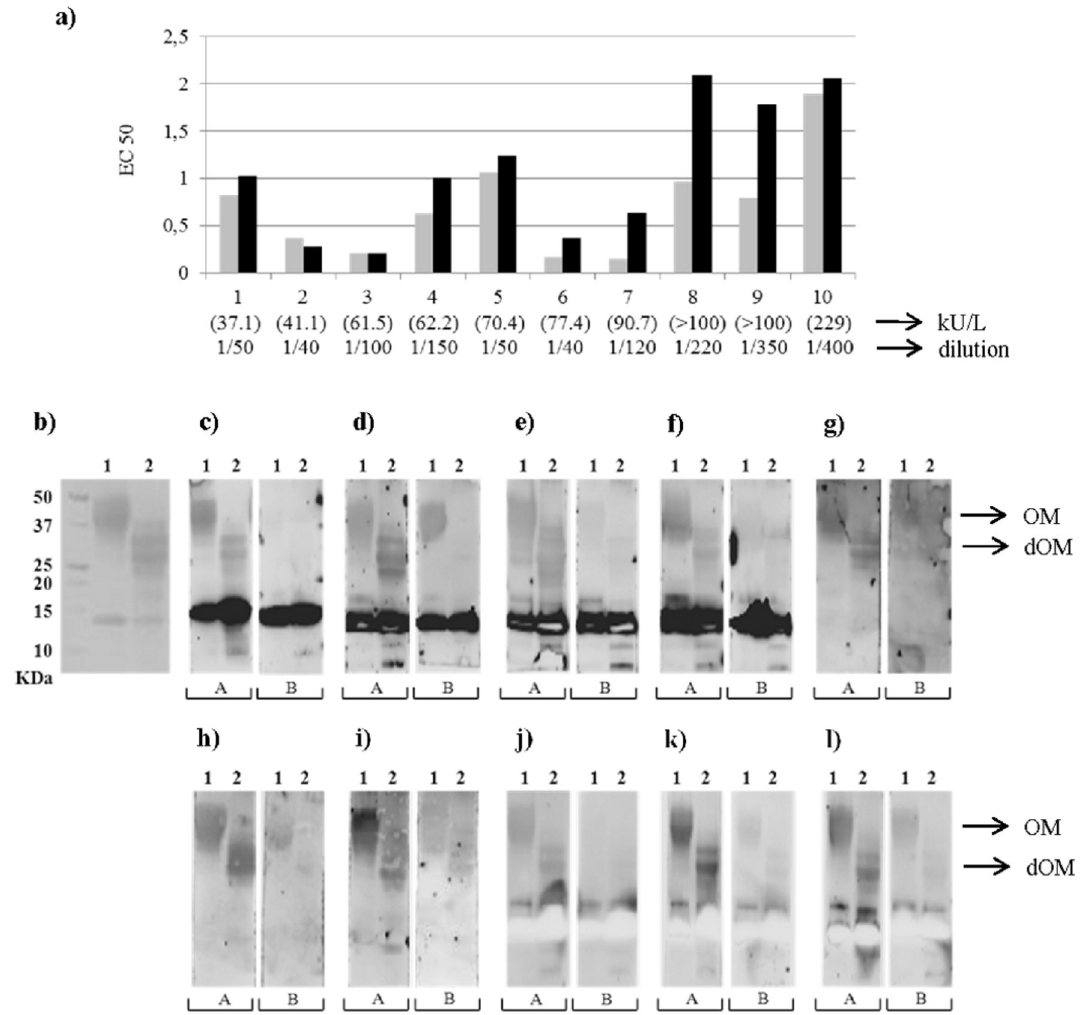
Figure 2. OM and dOM immunoreactivity . Binding to human IgE, using sera from 10 egg-allergic individuals (patients 1-10, Table 1), of OM (gray) and dOM (black), expressed as EC50, or effective OM or dOM concentration (μg/mL) to inhibit 50% of the IgE binding to OM (a). SDS-PAGE (b) and Western blot analyses (c-l) of OM (1) and dOM (2) with sera from the same 10 individuals (1-10, respectively, used in the ELISA). Human sera were either no incubated (A) or previously incubated (B) with the amount of dOM calculated to inhibit 100 % of IgE binding.